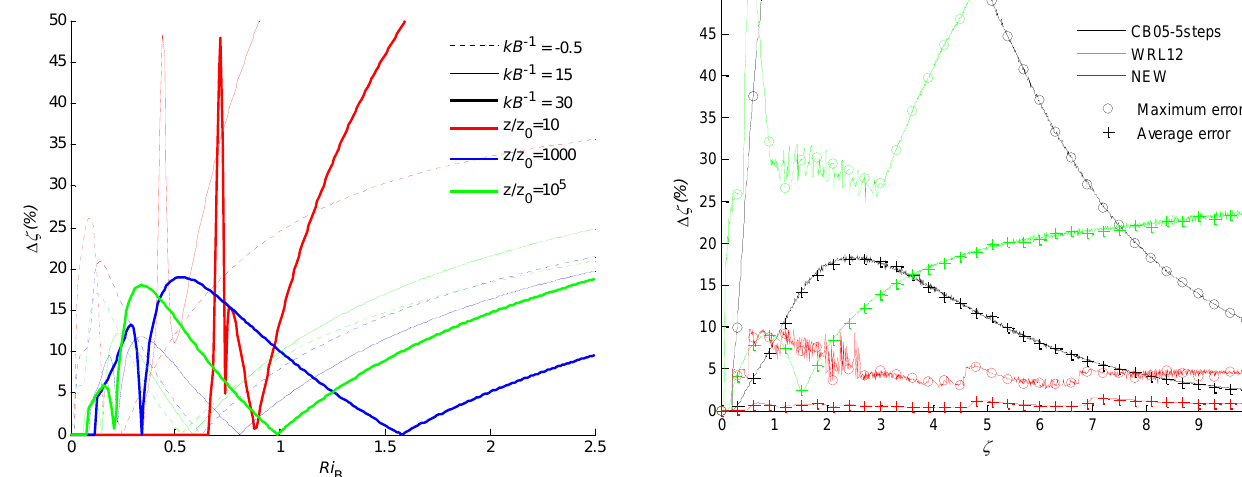
Fig. 6. Relative error with WRL12 equations. Figure 6. Relative error with WRL12 equations. 2